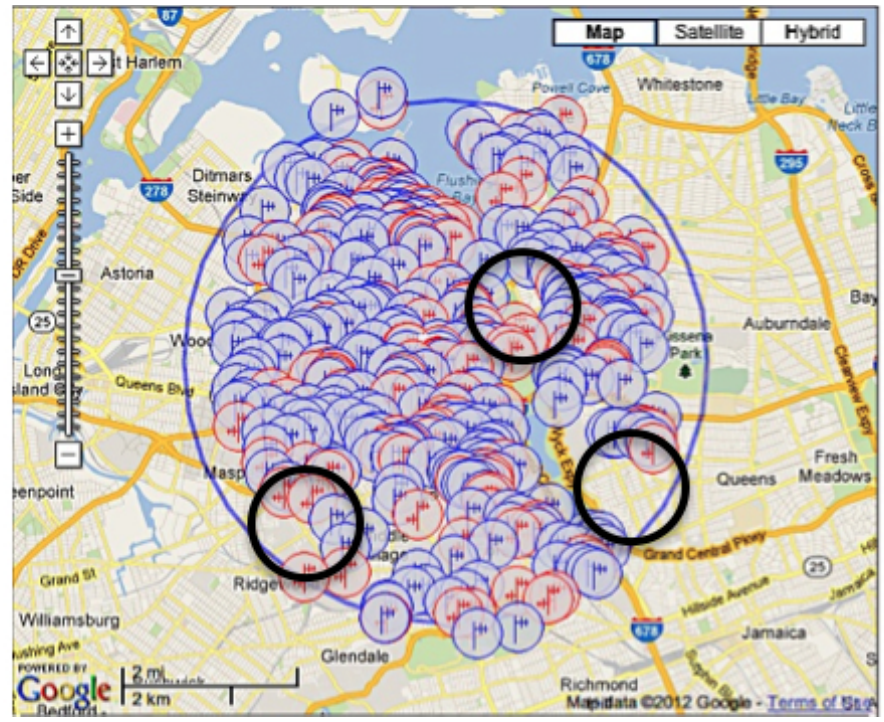
Figure 4. Antenna sites: Queens Borough, New York. Black circles indicate gaps in